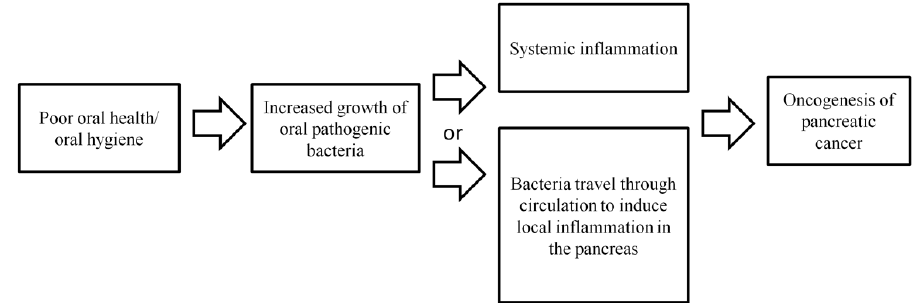
Figure 1. Possible biological mechanisms explaining the association between poor oral and microbiome and an increased pancreatic cancer health/hygiene and microbiome and an increased pancreatic cancer risk.